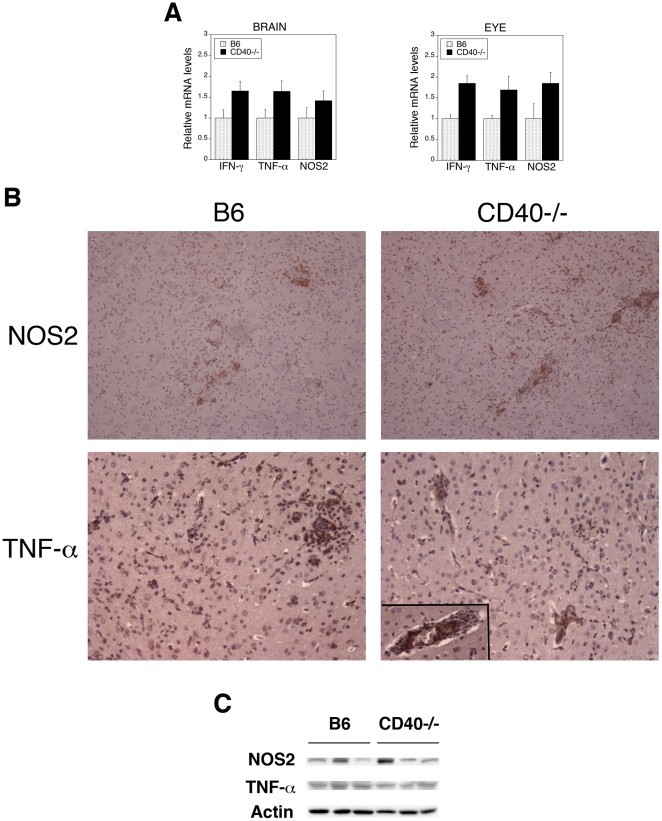

T. gondii-infected CD40−/− mice exhibit upregulation of IFN-γ, TNF-α and NOS2 in the eye and brain.B6 and CD40−/− mice were euthanized 4 weeks after infection with tissue cysts of the ME49 strain of T. gondii. A, Levels of IFN-γ, TNF-α and NOS2 mRNA in eyes and brains were examined using quantitative PCR and normalized against the levels of 18s rRNA. Each group contained 5 mice. Results are shown as the mean ± SEM. B, Brains were subjected to immunohistochemistry for NOS2 (X100) and TNF-α (X200). TNF-α was detected not only in the brain parenchyma but also within blood vessel walls in both B6 and CD40−/− mice (inset). C, Brains were lysed and subjected to immunoblot for NOS2, TNF-α and actin. Each lane represents one mouse. Results are representative of 3 to 4 independent experiments.